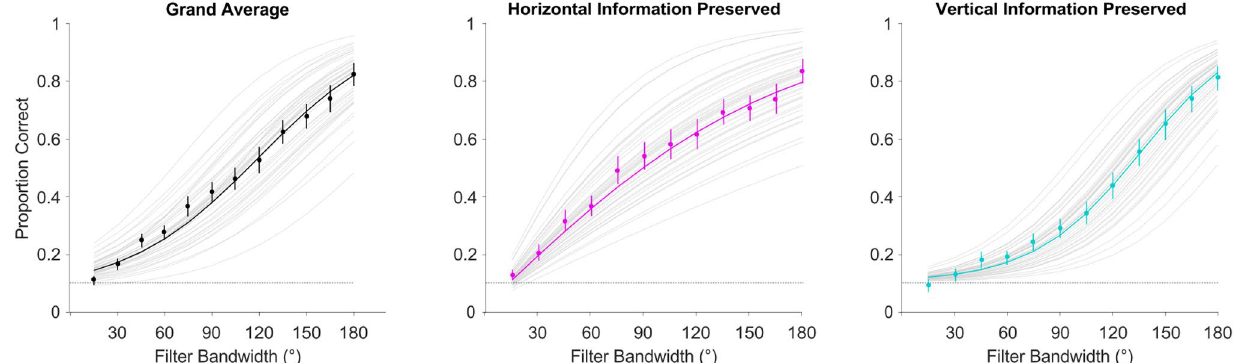
Figure 2. Logistic function fits to trial-level correct responding as a function of filter orientation in Experiment 2. Grand averaged data (left) are plotted alongside Model 2’s fit, with gray tracings displaying individual observers’ fits for comparison. Model 3’s fits to the orientation-split averaged data are plotted separately for images retaining horizontal (middle) and vertical (right) SF information, across filter bandwidth conditions. Error bars represent ± 1SEM; dotted lines represent chance